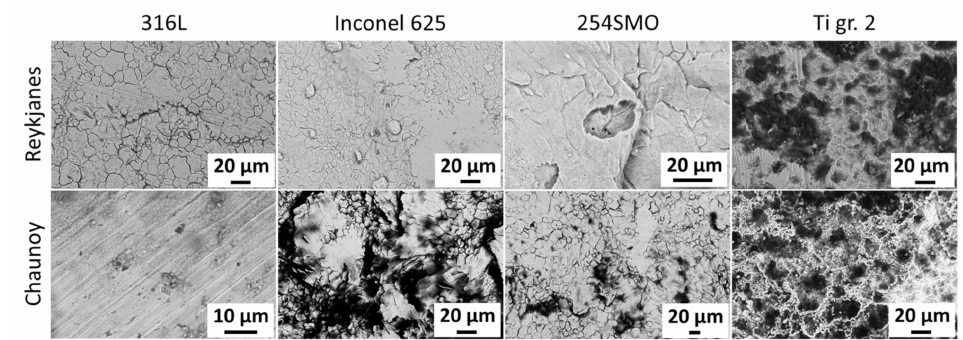
Figure 7. Topography images taken with Backscatter Electron (BSE) detector of the surfaces of the exposed